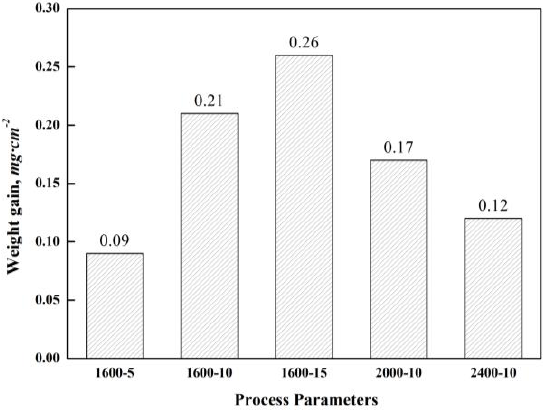
Figure 13. Final mass gain of the samples after high-temperature oxidation for 100 h .